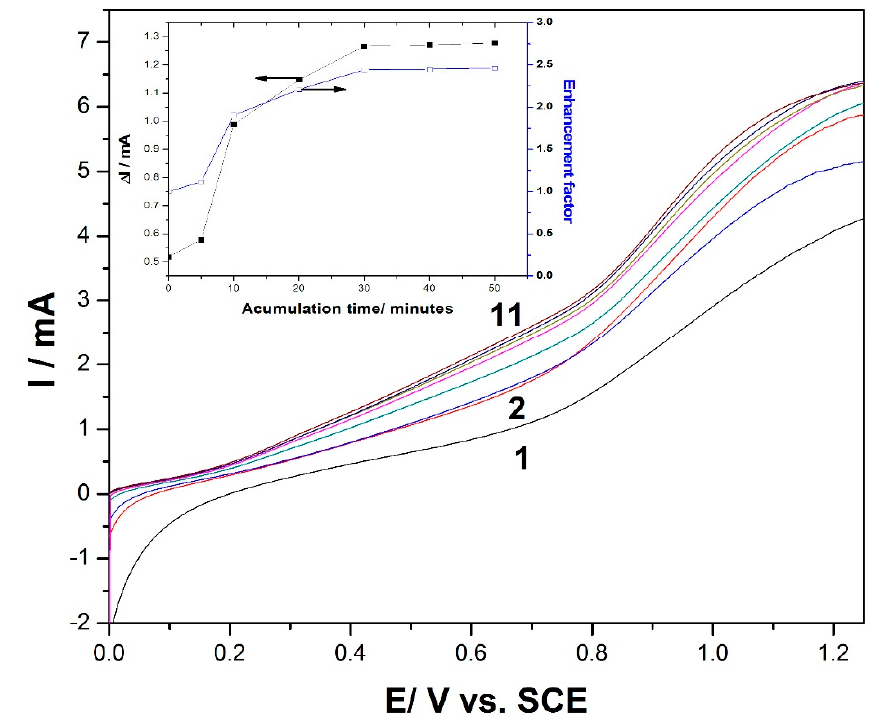
Figure 4. LSV recordings at the MWCNT-CuBTC composite electrode in 0.1 M of NaOH supporting electrolyte (curve 1) and in the presence of 1 mM of glucose at various accumulation times from 0 to 50 min (curves 2–11). The inset shows the evolution of the anodic peak current and the enhancement factor versus the accumulation time. Table 2. The electroanalytical parameters for glucose direct detection at the MWCNT-CuBTC composite electrode in 0.1 M of NaOH supporting